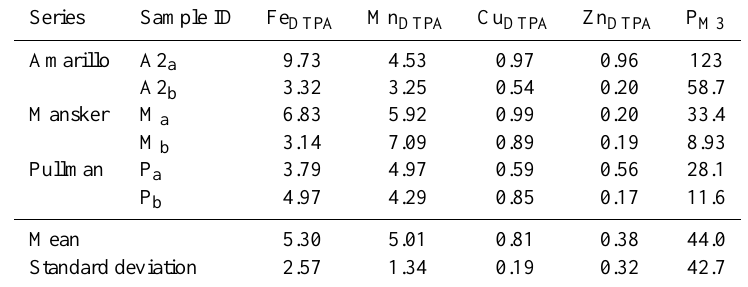
Table 3. Selected plant-available nutrients (in mgkg − 1 ) in the studied semiarid alkaline soils of the Southern High Plains, USA.